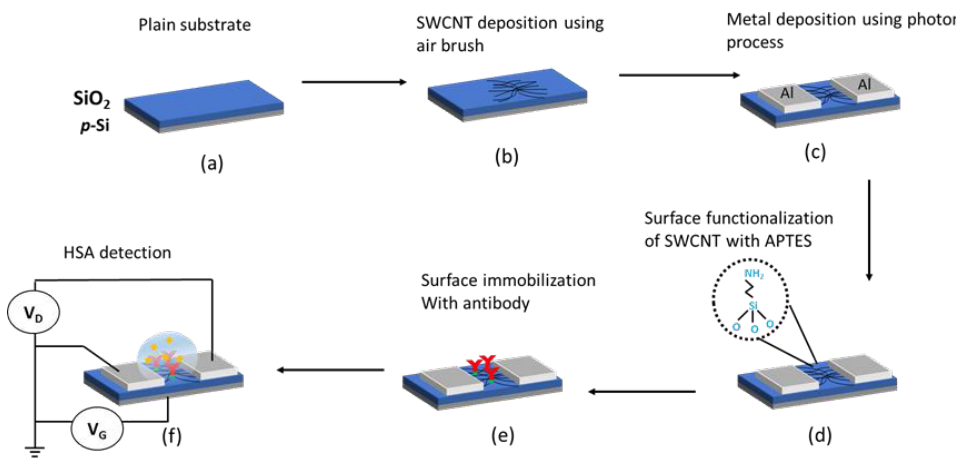
Figure 1. A schematic fabrication process of the CNT-FET device; ( a ) cleaned substrate, ( b ) SWCNTs deposition, ( c ) Al metal deposition, ( d ) surface functionalisation, ( e ) surface immobilisation with Ab, and ( f ) electrical measurement.